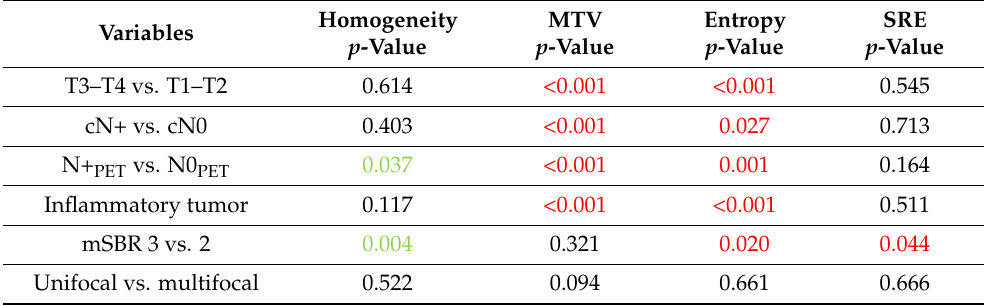
Green = negative statistically significant association. Red = positive statistically significant